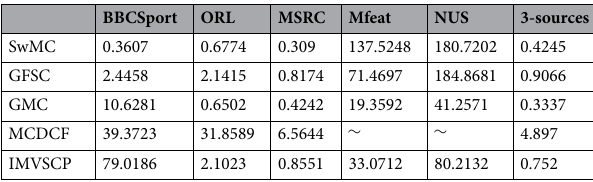
Table 9. Comparison of running time of some algorithms